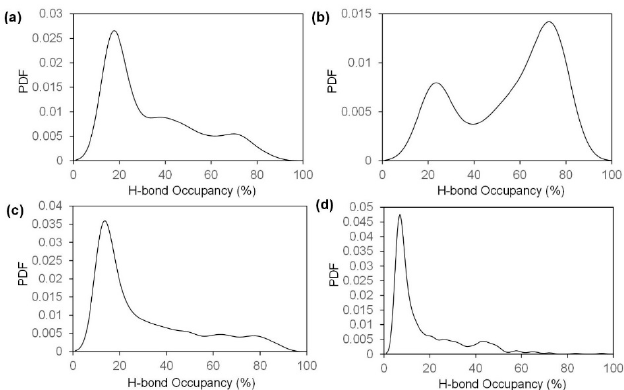
Figure 2 . Probability density function (PDF) of H-bond occupancy for each pulling condition based on the last 600 ps of equilibrium simulation. Higher occupancy indicates a stable H-bond. ( a , b ) Pulling along inter-chain direction and inter-sheet direction in chitin model; ( c , d ). Pulling along inter-chain direction and inter-sheet direction in an 85% chitosan model.